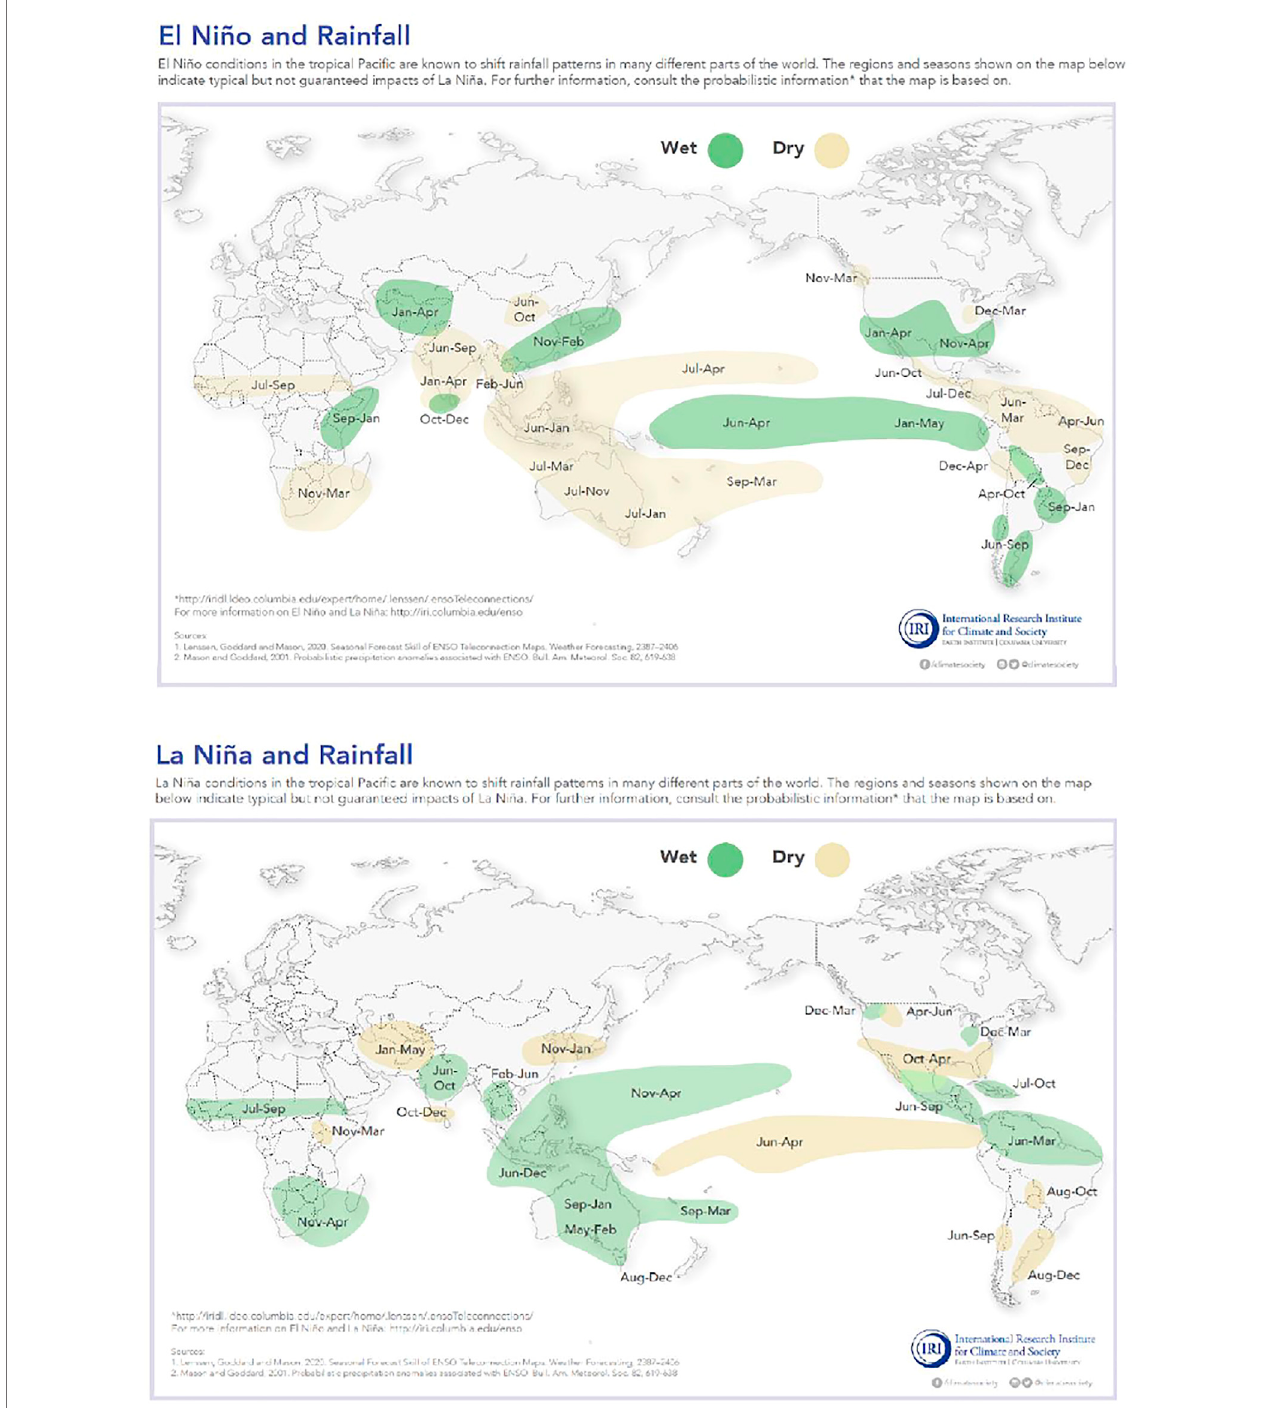
FIGURE 1 | EL Niño and La Niña effects. Notes: This fi gure indicates the weather patterns during El Niño and La Niña events. Source: International Research Institute for Climate and Society at Columbia University, based on Lenssen et al. (2020) and Mason and Goddard (2001).